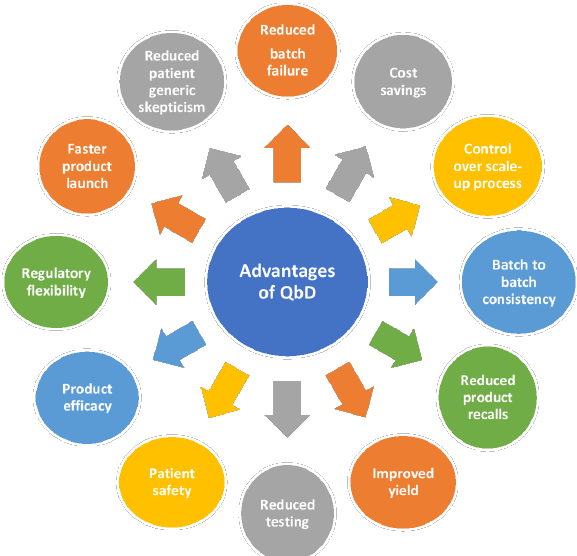
Figure 1. Advantages of QbD over the conventional